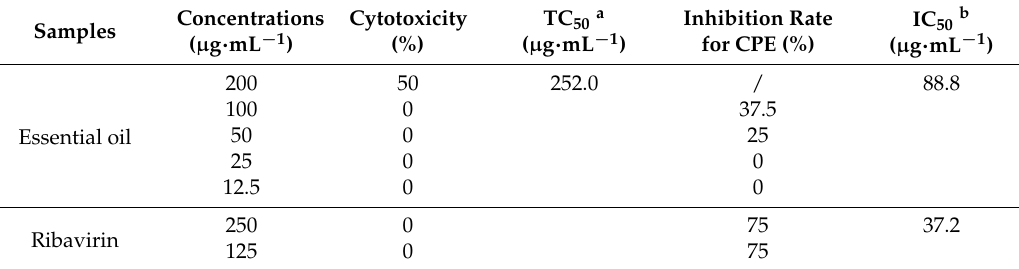
Table 2. In vitro antiviral activity against H 3 N 2 of W. glabra essential oil.